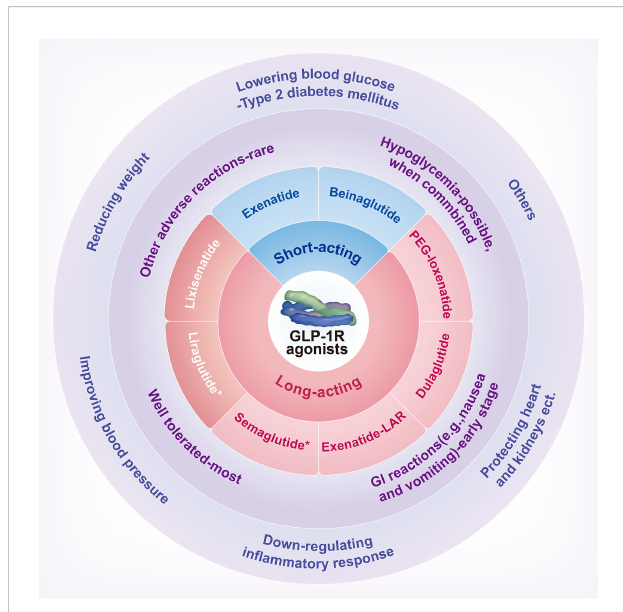
SCHEME 1 A schematic overview of GLP-1 receptor agonists: classi fi cation, drug safety, and effectiveness. GI, Gastrointestinal; GLP-1R, Glucagon-like peptide-1 receptor; PEG, Polyethylene glycol. *Liraglutide and Semaglutide have been approved by the United States Food and Drug Administration for weight loss.